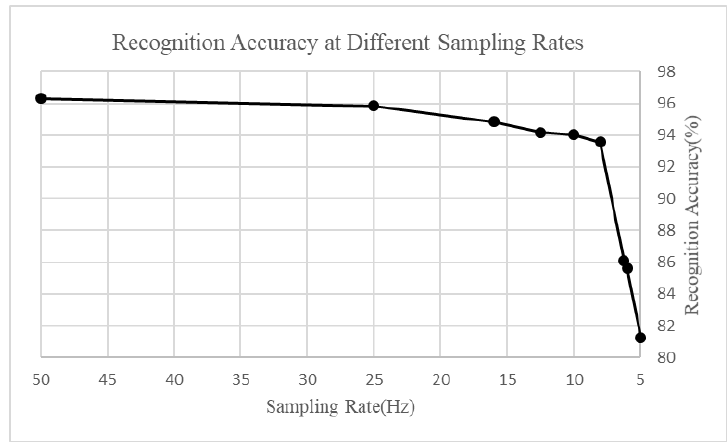
Figure 4. Recognition with a different sampling rate.